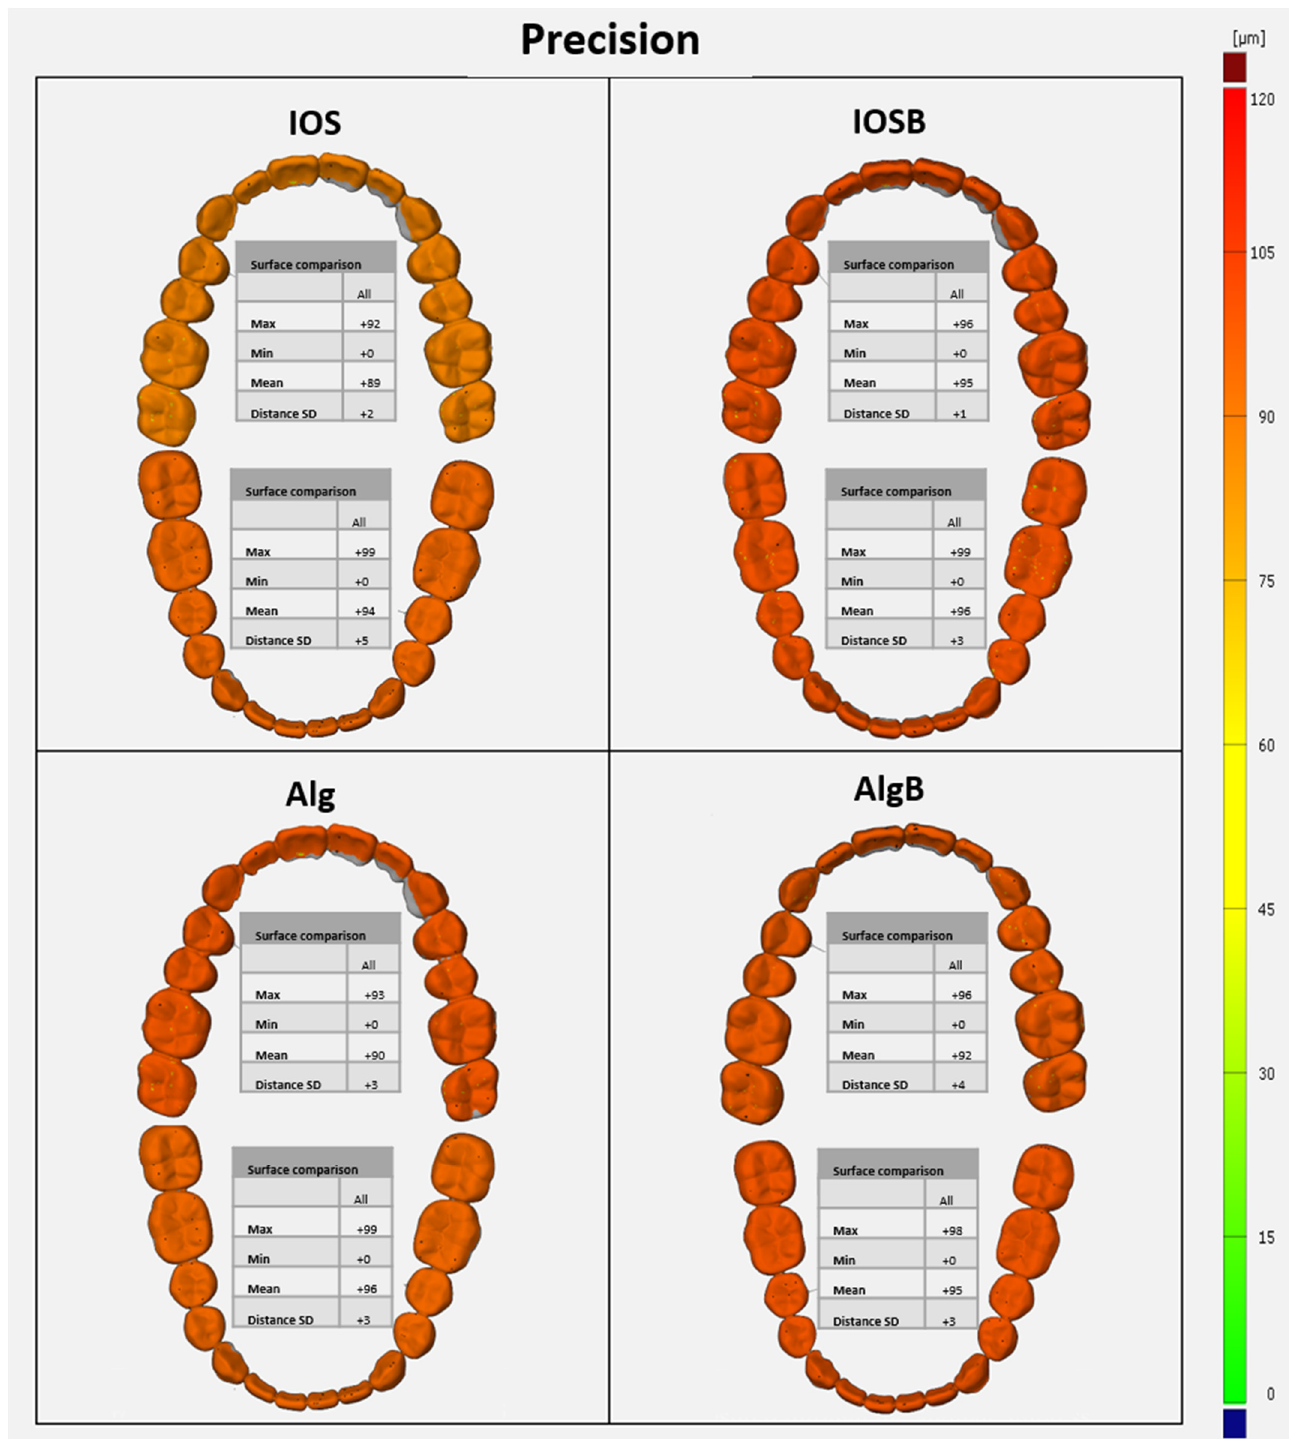
Figure 6. Color maps showing the precision assessment measured through the alginate impression and TRIOS3 ® intraoral scanners.